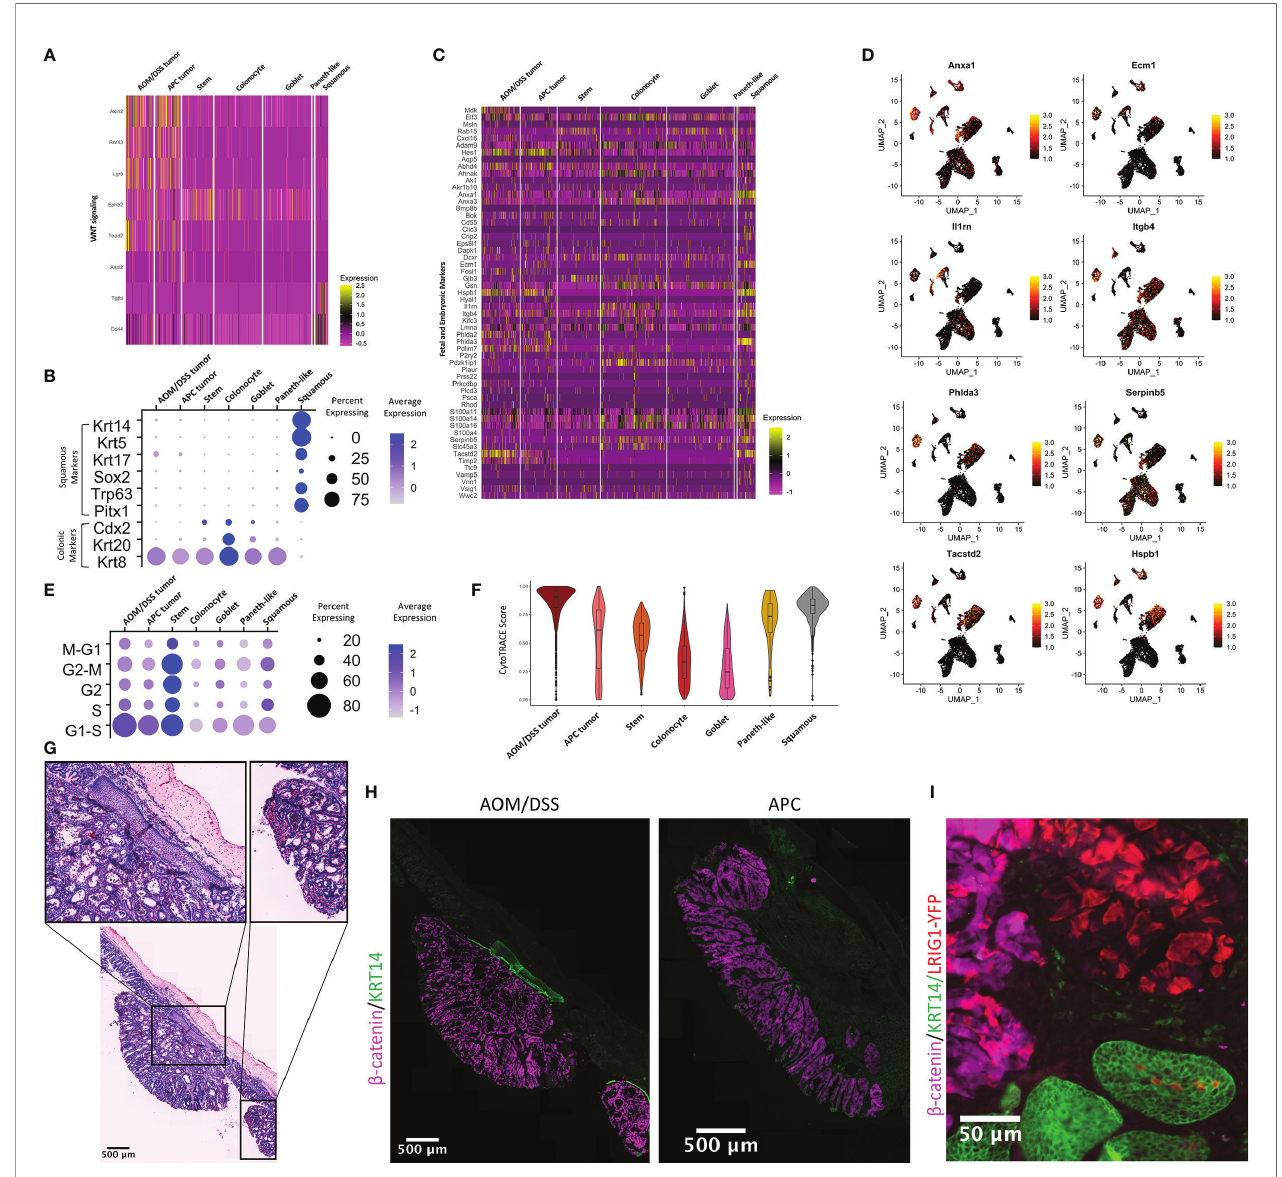
FIGURE 4 | Characterization of the squamous component present in AOM/DSS, but not APC, tumors. (A) Heatmap of genes related to WNT signaling and colonic stem cells. Columns represent single cells, arranged by epithelial cell type clusters. (B) Dot plot showing colonic or squamous identity genes for epithelial cell clusters, where clusters include cells from both APC tumor and AOM/DSS tumor samples. (C) Heatmap of fetal and embryonic programs. Columns represent single cells, arranged by epithelial cell type clusters. (D) UMAPs of scRNA-seq data with expression overlay, indicated by the color gradient, of selected fetal and embryonic genes. (E) Dot plot showing cell cycle meta-genes for each cell cycle phase in epithelial cell clusters. (F) CytoTRACE scores for epithelial cell types calculated from scRNA-seq data. (G) Representative H&E image of multiple AOM/DSS tumors within the same animals, with a focus on squamous components (insets). (H) Representative MxIF image of KRT14 in APC tumors and AOM/DSS tumors. Images were representative of n = 5 AOM/DSS tumors and n = 3 APC tumors. (I) Observation of Lrig1 CreERTe/+ ; Rosa YFP/+ traced cells within a single squamous cell region of an AOM/DSS